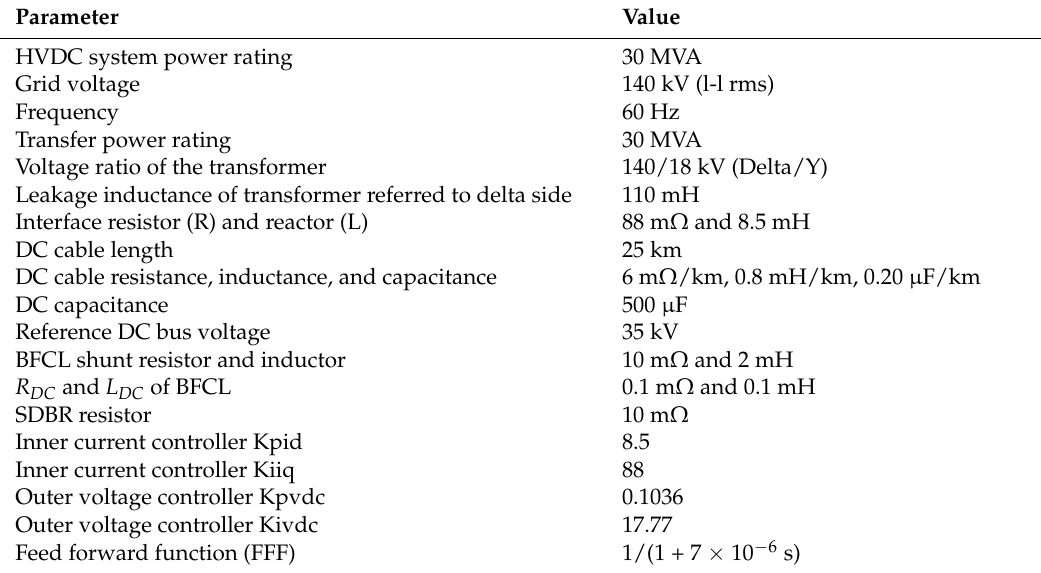
Table 1. HVDC system